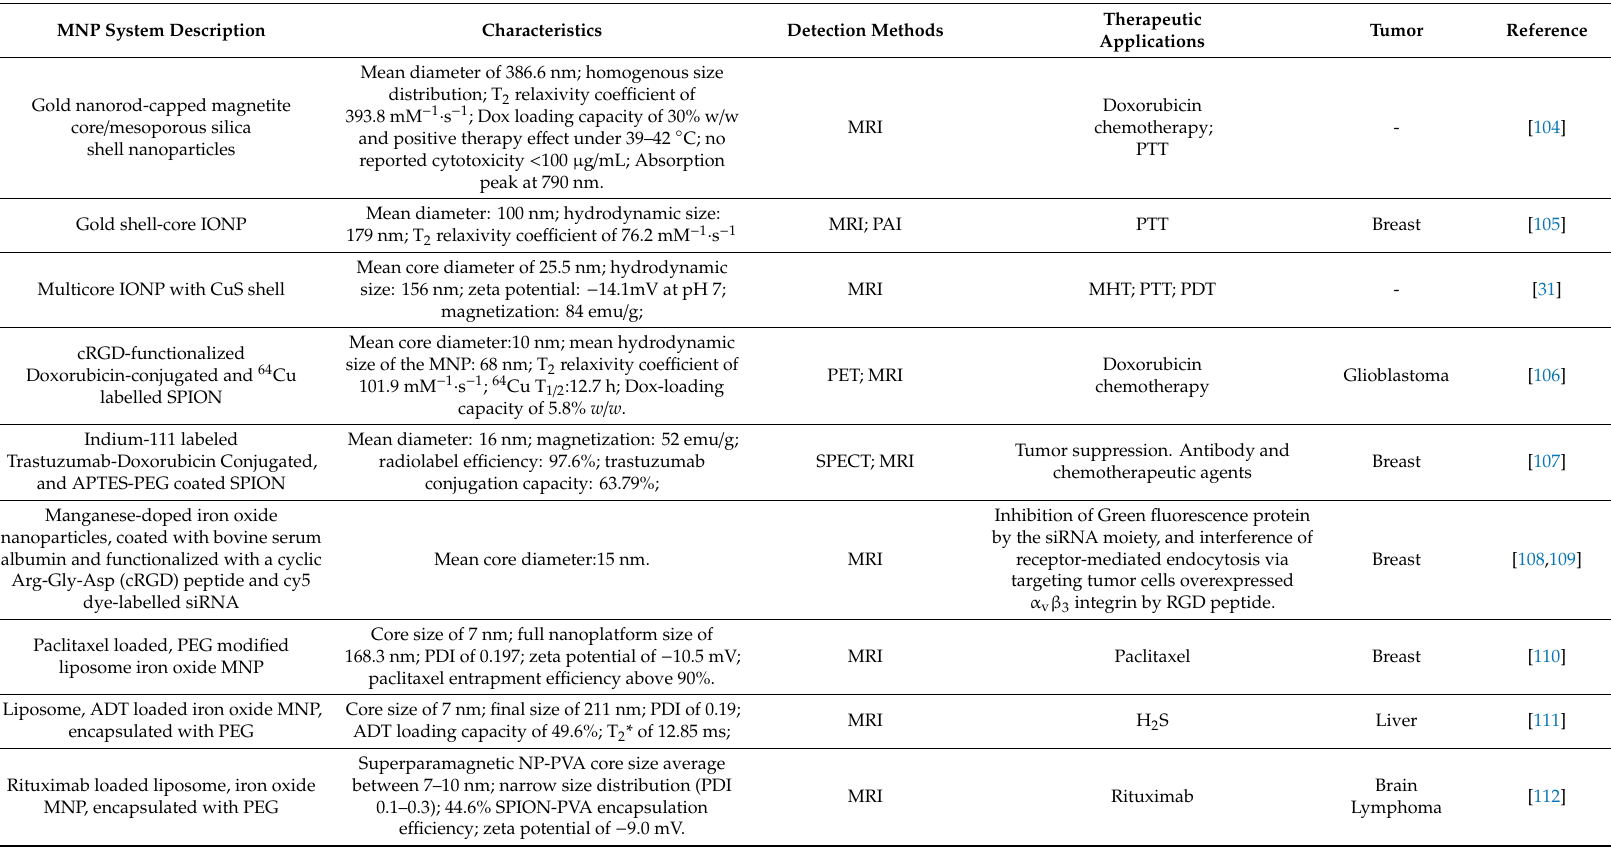
Table 3. Magnetic nanoparticles tuned for dual imaging and therapeutic